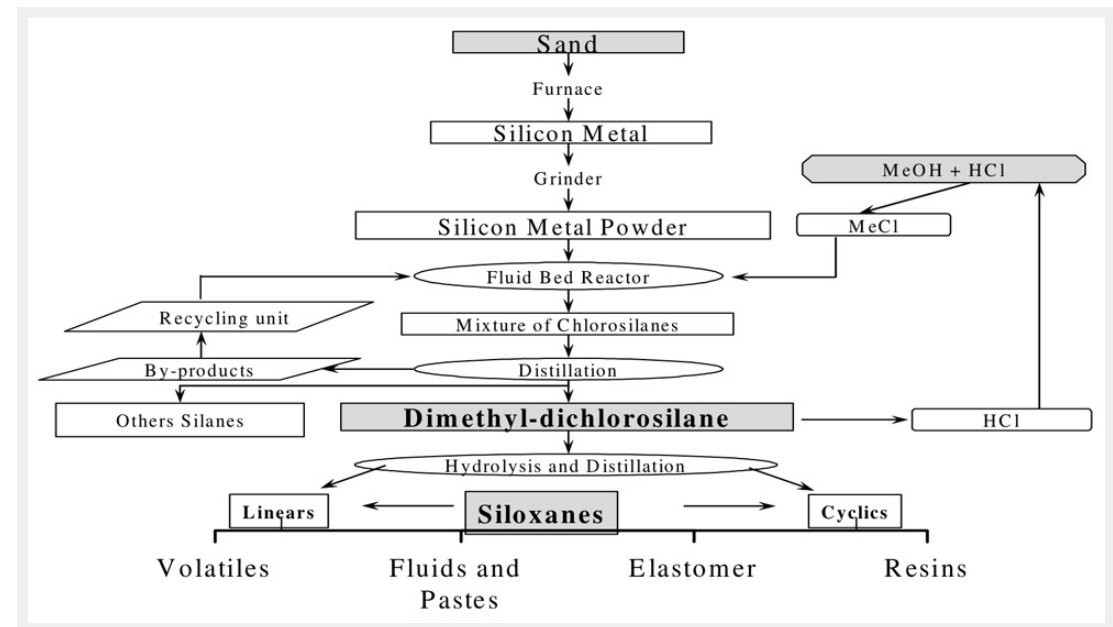
Figure 3 Flow chart of the process – starting with sand – for making siloxane-based materials, including silicone rubber and silicone gel used in breast implants. Source: Wikimedia Commons, © Naweedkhan.